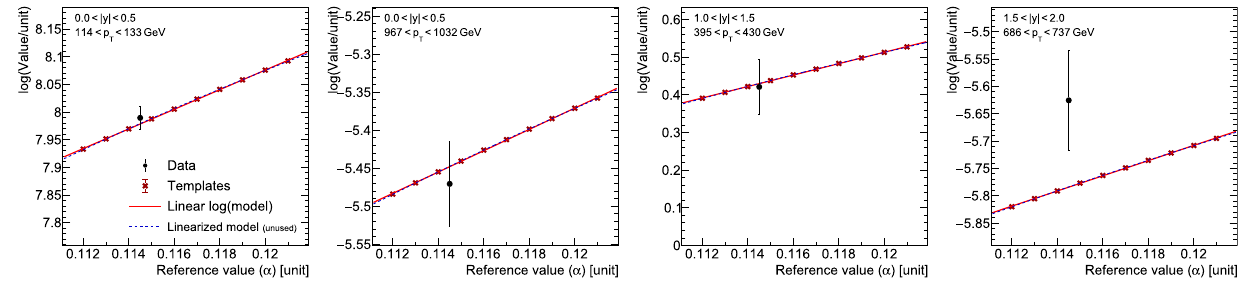
Fig. 11 Similar visualization of the templates than in Fig. 8, but using relative uncertainties (log-normally distributed PDFs) in the Linear Template